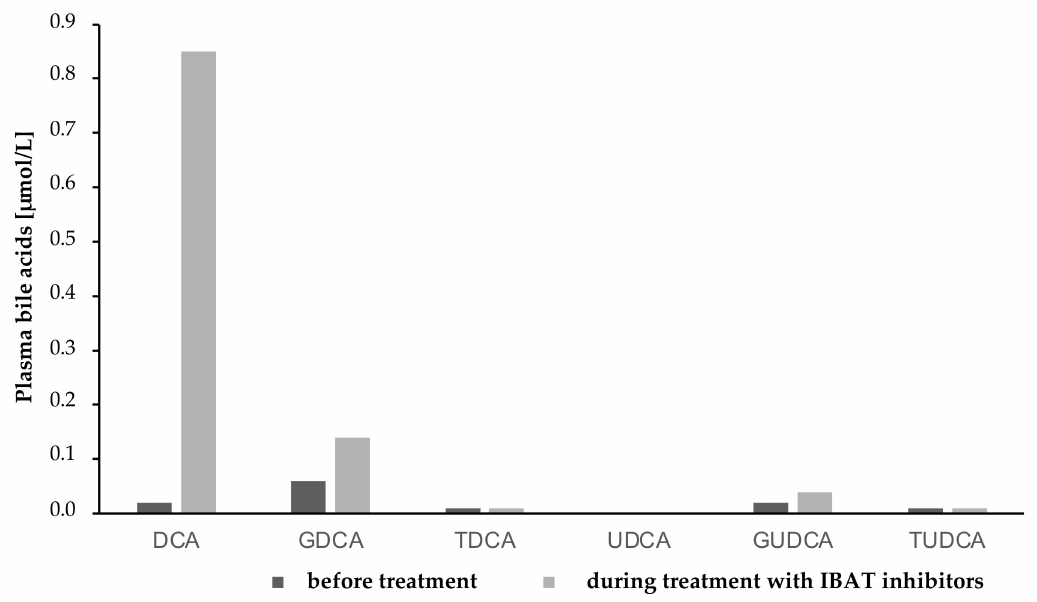
Figure 6. Secondary bile acids and their conjugates in plasma before and during treatment with IBAT inhibitors. DCA, Deoxycholic acid; GDCA, Glycodeoxycholic acid; TDCA, Taurodeoxycholic acid; UDCA, Ursodeoxycholic acid; GUDCA, Glycoursodeoxycholic acid; TUDCA, Tauroursodeoxycholic acid; IBAT, ileal bile acid transporter